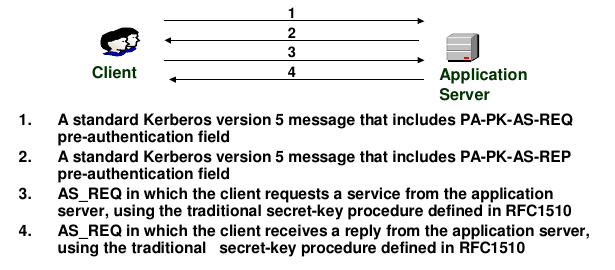
Figure 2. The PKTAPP Message Flow Table 1. The Operations of Encryption and Decryption When n Application Servers are in m Remote